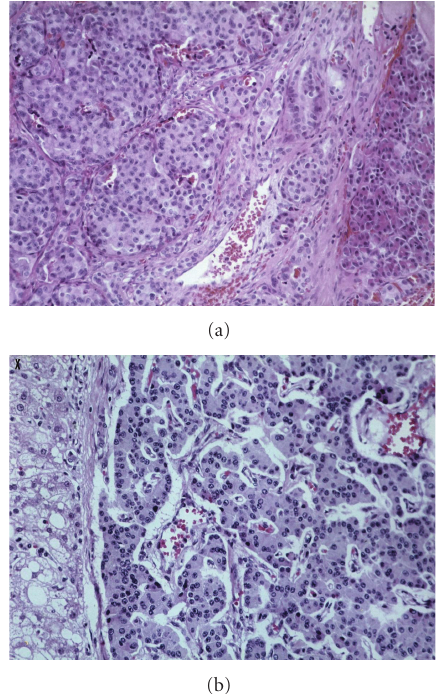
Figure 1: (a) Microscopic features of the excised insulinoma. Histo- morphologically, a solid pattern was predominated. Moderate sized tumour cells formed solid cellular sheets, poorly defined trabeculae and pseudoglandular structure ( × 200 magnification). (b) Tumour cells showed mild atypias with nucleolar enlargement a slightly increased nuclear/cytoplasmatic ratio and nuclear crowding. No mitotic activity was observed but the proliferative rate was found slightly increased ( × 400 magnification).